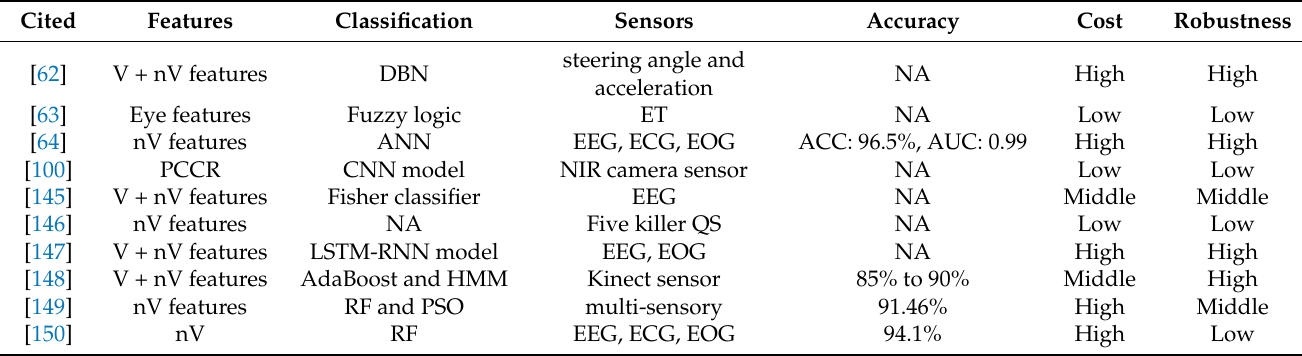
Table 1. Multi-sensor based architectures used by current state-of-the-art DFD